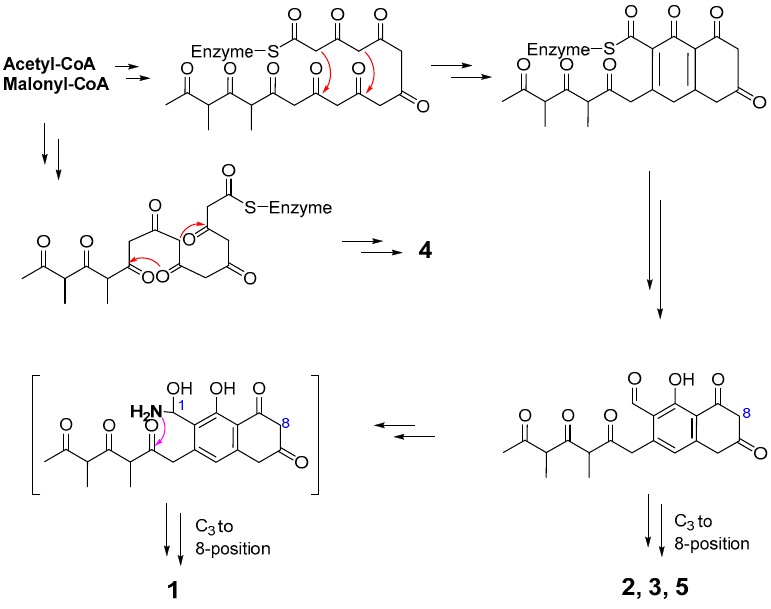
Figure 3. Proposed biosynthesis of compounds 1 – 5 .